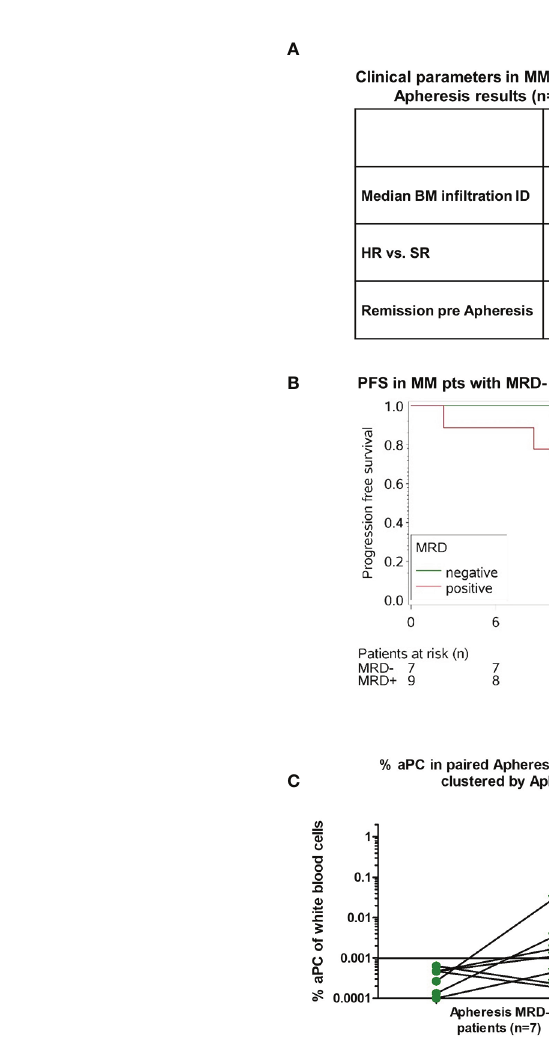
FIGURE 3 | Analysis of apheresis samples. (A) Clinical parameters of MM patients with MRD - vs. MRD + apheresis product results. Remission pre-apheresis according to International Myeloma Working Group (IMWG) criteria, median BM in fi ltration at ID, and cytogenetics (high risk vs. standard risk) of 16 patients assessed at stem cell harvest were compared based on MRD status in apheresis samples (MRD - n = 7; MRD + n = 9; Sensitivity 10 -5 ). (B) The Kaplan-Meier curve shows the progression-free survival (PFS) of patients with MRD - apheresis samples compared to MRD + apheresis samples (p = 0.12; log-rank test). (C) Percentage of aPC in paired apheresis and under treatment BM samples, clustered by apheresis-MRD status (n =